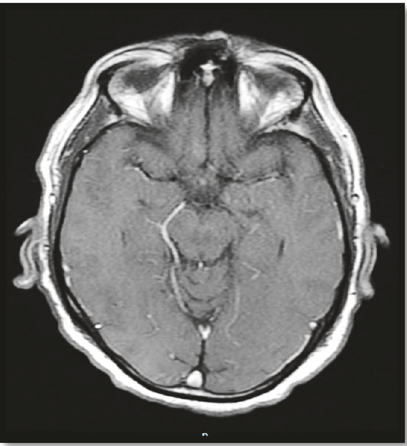
Figure4:PeriictalbrainMRIwithcontrastshowingnocorrespond- ing area of enhancement. Abbreviation: MRI, magnetic resonance imaging.